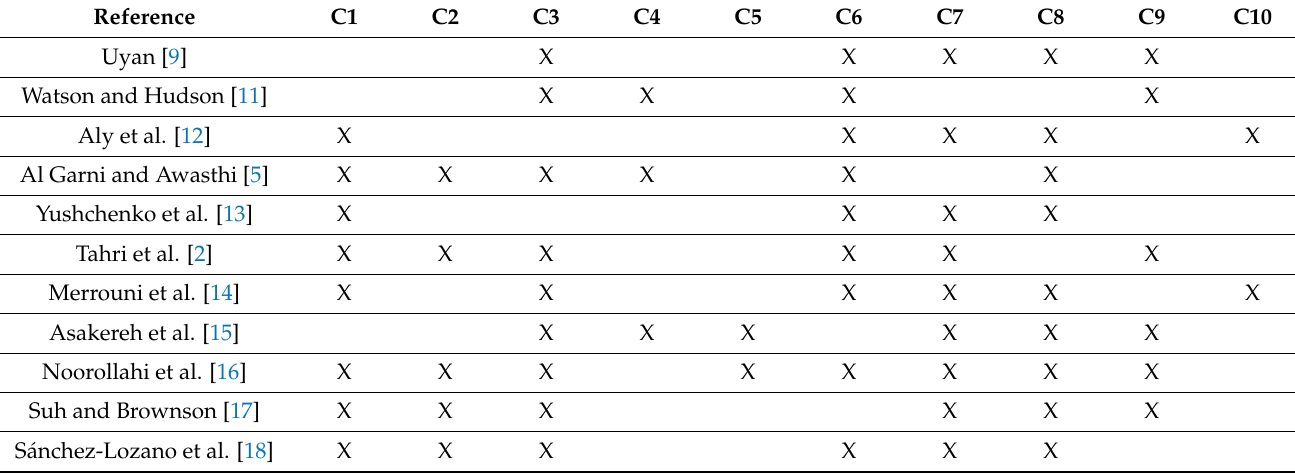
Table 2. Criteria considered in previous studies for analyzing photovoltaic (PV) site suitability.